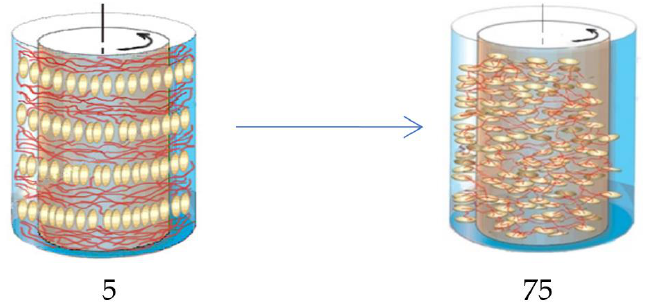
Figure 20. Evolution of clay particles ordering in shearing time, min, indicated by digits.